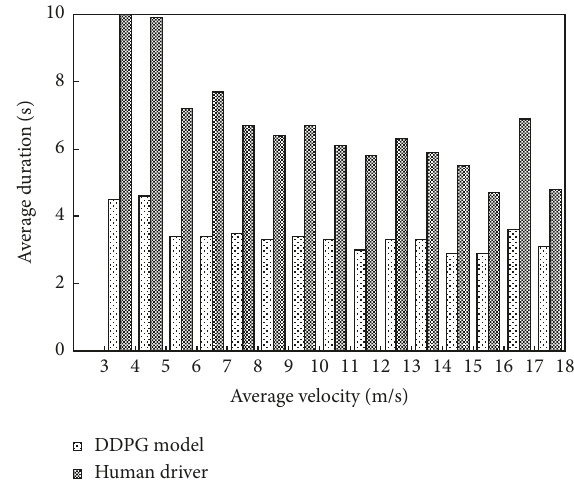
Figure 9: Lane-changing duration distribution.